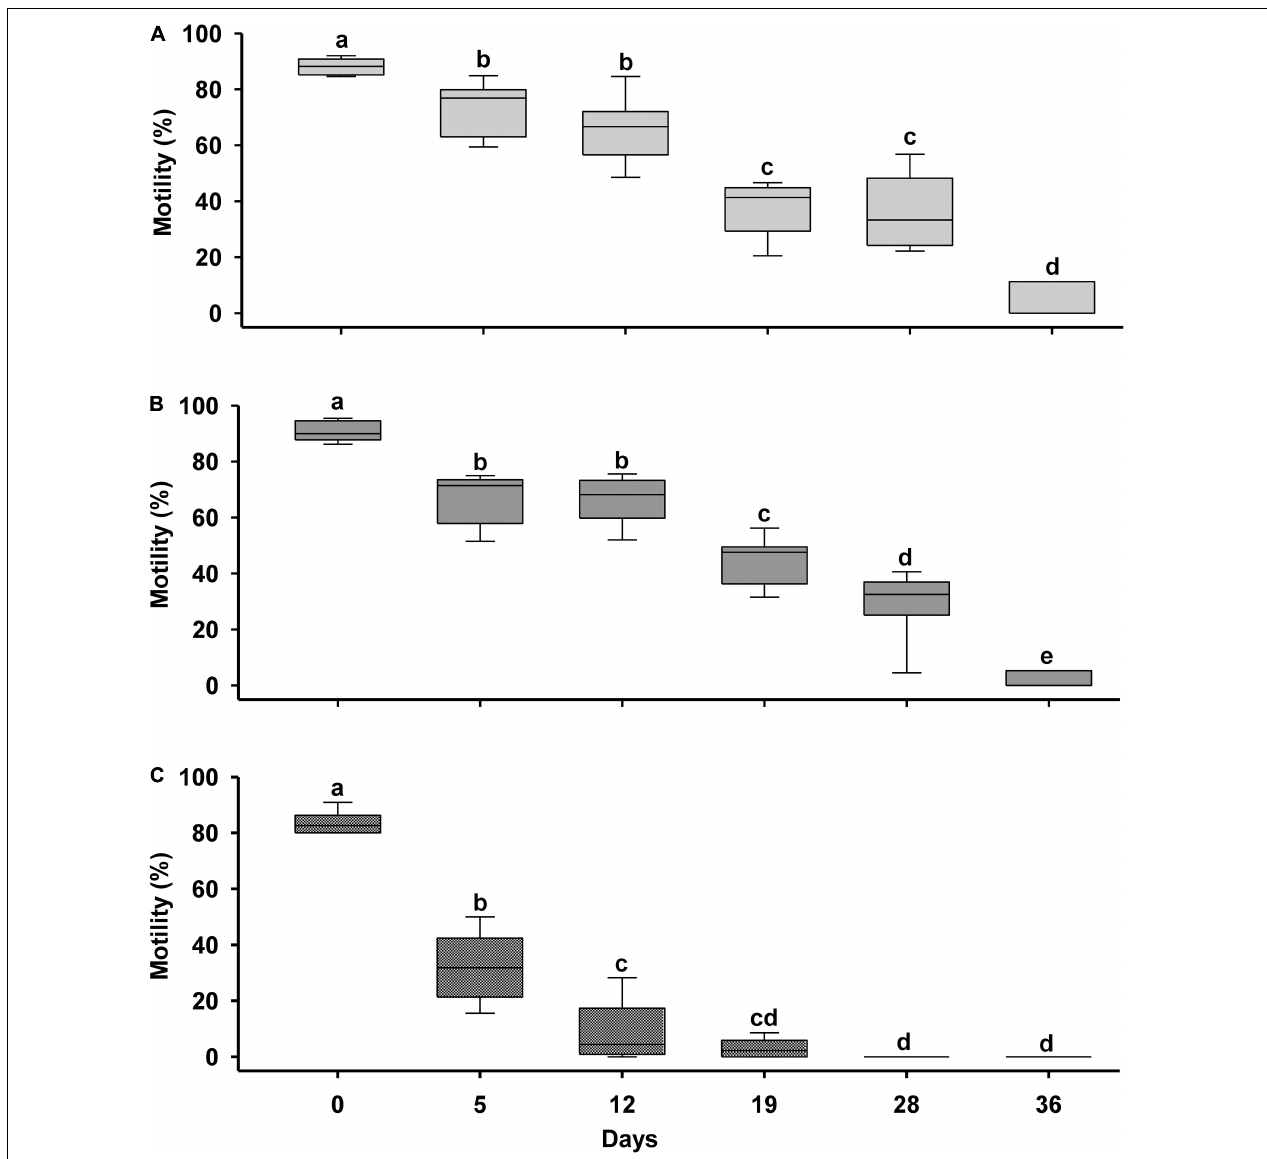
FIGURE 4 | Media comparison for short-term preservation. Short-term preservation results after diluting 1:9 (sperm: dilution medium) Scyliorhinus canicula sperm with three diluents. (A) Artificial elasmobranch seminal plasma extender (EE); (B) artificial seminal plasma extender variant (EEV); (C) sea water (SW). Motility was assessed on different days (D) after initial dilution (CONTROL). Different letters mean significant motility differences between days into every